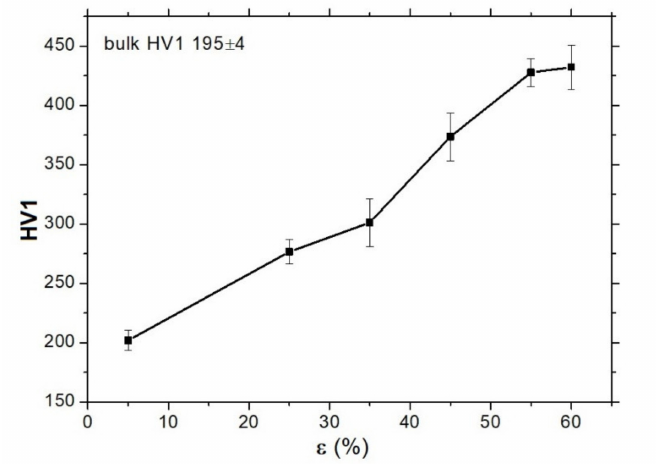
Figure 5. The influence of plastic straining on hardness of AISI 321.